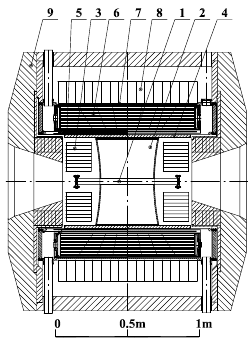
Figure 1. CMD-3 detector: 1 – beam pipe,